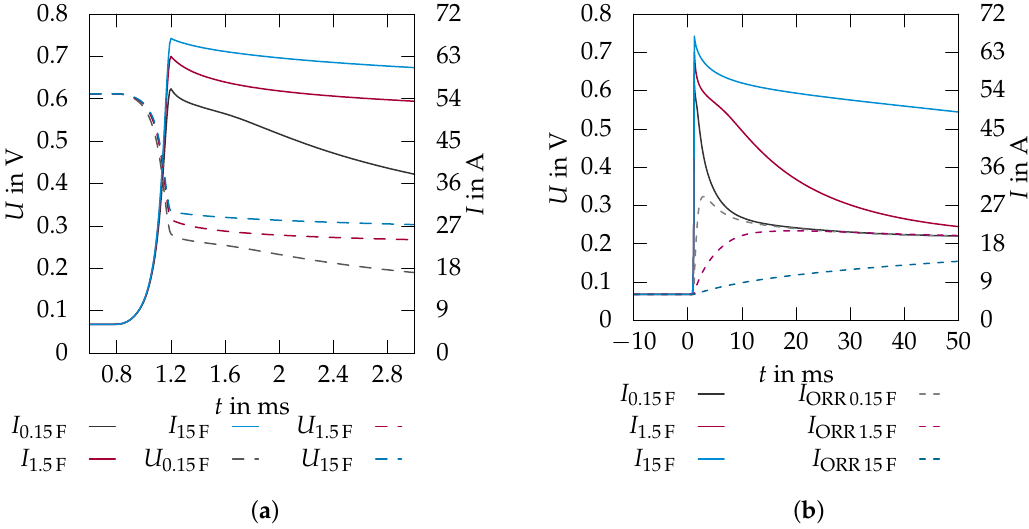
Figure 16. ( a ) Current (solid) and voltage (dashed) in the transient simulation of the SC with a variation in the DL capacity at a stationary load of 0.1 Ω prior to the SC. ( b ) Total (solid) and reaction current (dashed) up to 50ms for the different DL capacities.